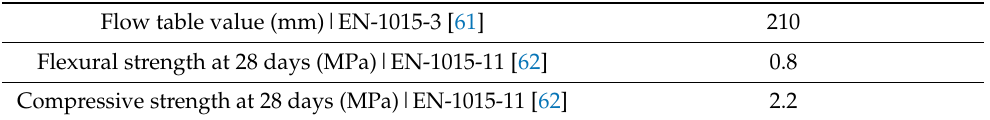
Table 6. Properties of the cement–soil mortar used in the experimental program (adapted from Ribeiro